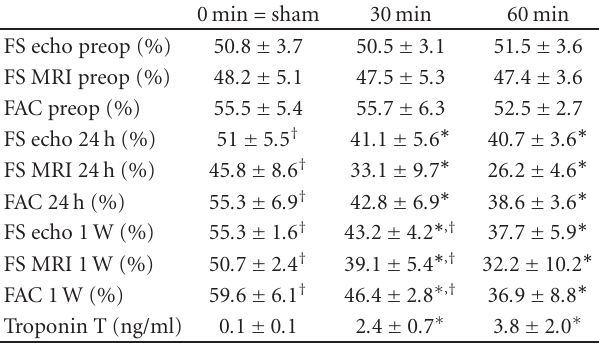
Table 2: Cardiac functional parameters. Fractional shortening (FS) determined by echocardiography and cine magnetic resonance imaging (MRI), fractional area change (FAC) determined by cine magnetic resonance imaging. Values shown as mean percentage ± standard deviation before (preop), 24h and 1 week after ischemia/reperfusion procedure for mice with no ischemia (sham), 30min or 60 min of ischemia during procedure. Troponin T levels (ng/ml) are shown for each group. ∗ Significant di ff erence to sham- operated mice; † Significant di ff erence to 60min operated mice; all P < . 05. 0min =